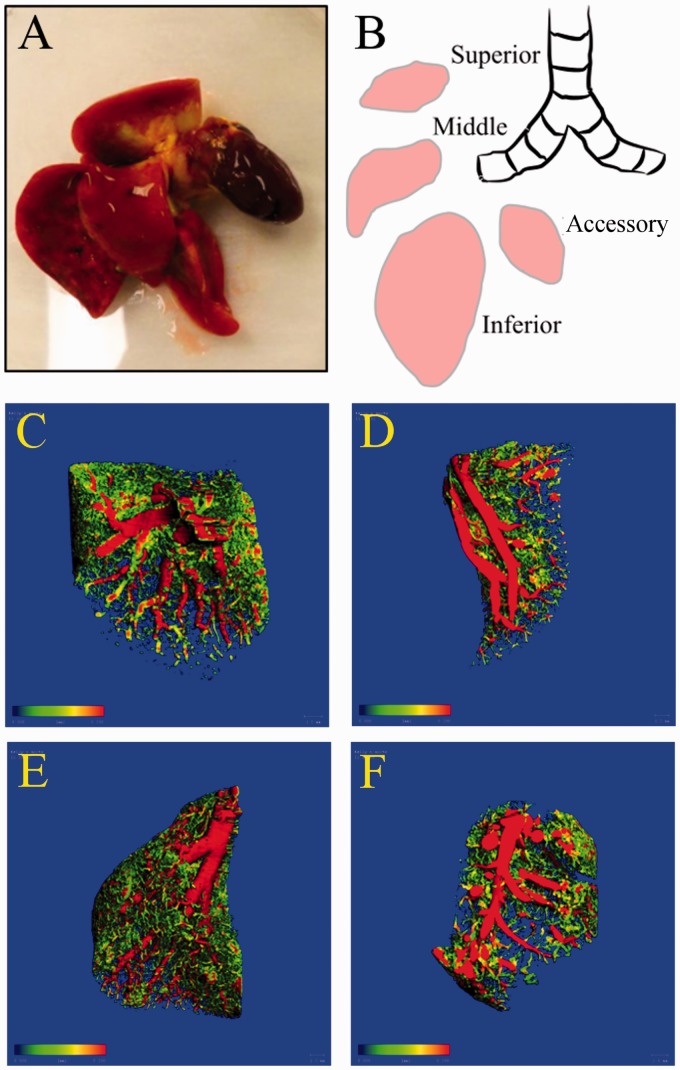
The right lung of the rat: (a) the right lung and heart with Microfil (yellow) is placed into 10% neutral buffered formalin before microCT scanning; (b) schematic of right lung lobes. Representative 3D images of SU/hyp right lung lobes: (c) superior = lobe 1, (d) middle = lobe 2, (e) inferior = lobe 3, (f) accessory = lobe 4 (scale bar range: 0.000 (blue) to 0.200 (red) mm).